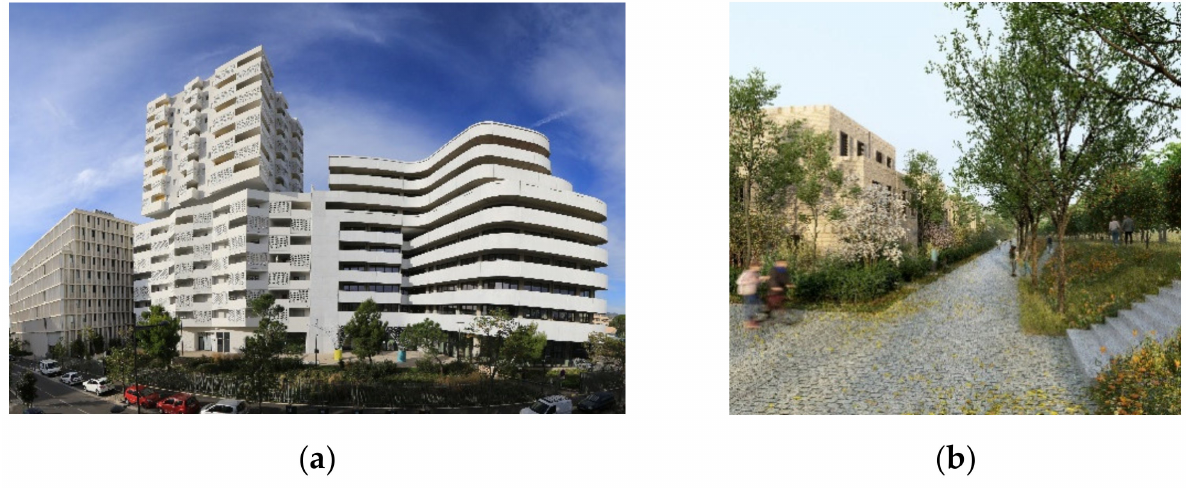
Figure 10. ( a ) Smartseille (© Action Photo Video Thierry Lavernos/Eiffage); ( b ) Quartier de Gally (© ICADE). On average, projects explore two different levels of integration. Three projects explored just one level (CIRC, Nianing Church and Tour D2), and only one project explored all the dimensions (P ô le d’Excellence sur le Biomim é tisme